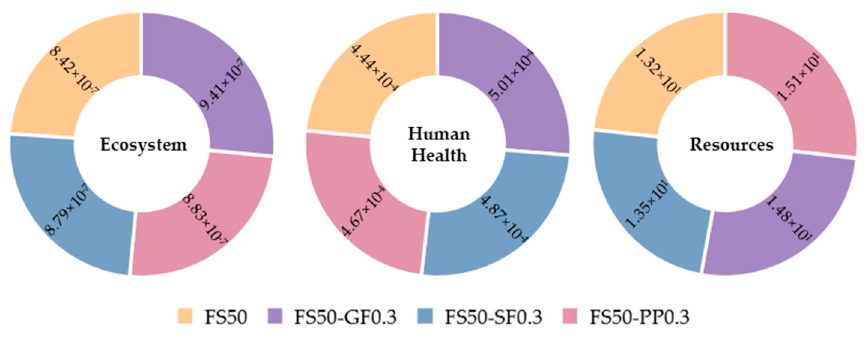
Figure 9. Endpoint impacts of